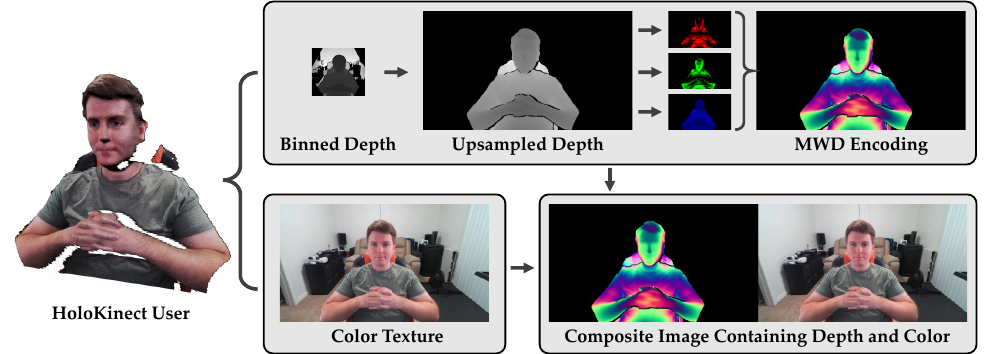
Figure 2. HoloKinect encoding pipeline. Depth and color maps are are collected at 30 FPS from the Microsoft Azure Kinect. In this work, we focus on a 320 × 288 depth map, binned down from a 640 × 576 depth map collected using the Kinect’s narrow field of view option. The 320 × 288 depth map is transformed and linearly interpolated to the perspective and resolution of the color camera (1280 × 720). Depth values outside of the range [ Z min , Z max ] are thresholded. Multiwavelength depth (MWD) encodes the 16-bit depth measurements into the red, green, and blue channels of a standard RGB image using Equations (1)–(3), respectively. This 1280 × 720 MWD encoding is combined side-by-side with the color texture to create a 2560 × 720 composite frame. This composite frame is then readied for video compression and